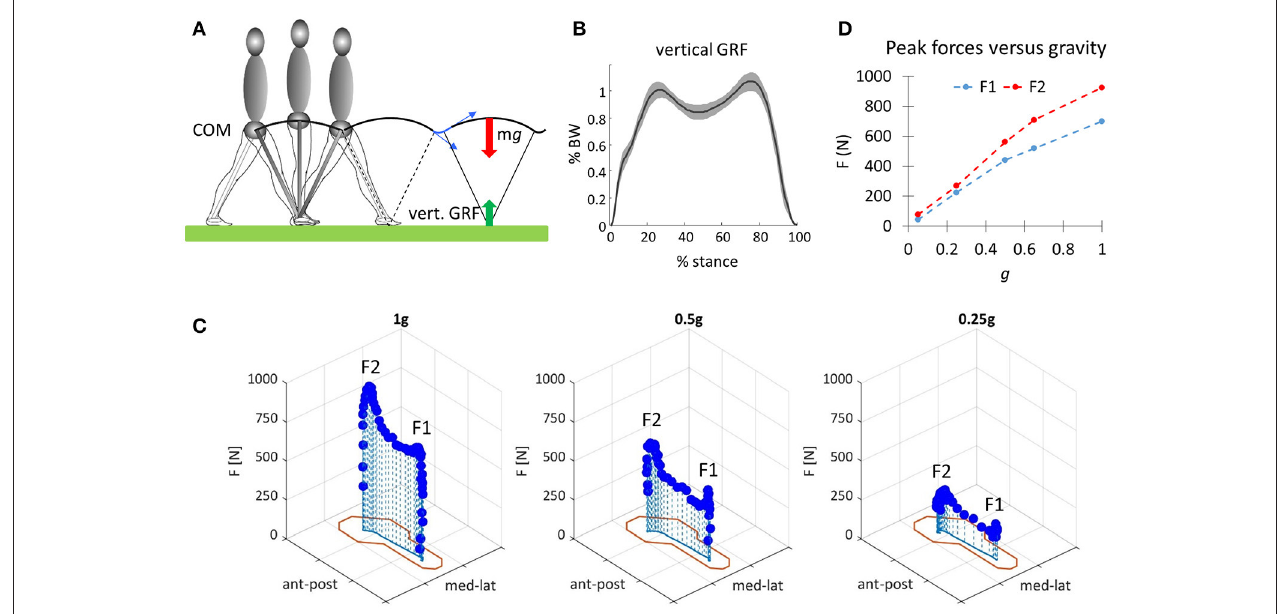
FIGURE 1 | (A) Schematic illustration of the pendulum-like behavior of the center-of-body mass (COM) during walking. Red and green arrows denote body weight and vertical ground reaction force (GRF), respectively. Blue arrows denote COM velocity before and after heel contact (step-to-step transitions). (B) Ensemble average ( ± SD , 20 subjects, normalized to individual body weight BW) of the time profile of the vertical ground reaction force (GRF, recorded with a force plate) plotted vs. normalized stance duration. Data replotted from Martino et al. (2014). (C) Changes of the vertical component of in-shoe reaction forces plotted as a function of the spatial coordinates of the foot (outline in red corresponding to the outer elements of the pressure-sensitive matrix interposed between foot and shoe) at three different levels of gravity obtained in the laboratory with a vertical body-weight supporting (BWS) system: 1g (0 BWS), 0.5g (50% BWS), and 0.25g (75% BWS). F1 and F2 denote the two main peaks of force. (D) Mean values of the first (F1) and second (F2) peaks derived from force records such as those of C plotted as a function of gravity level. Data of (C,D) are replotted from Ivanenko et al.